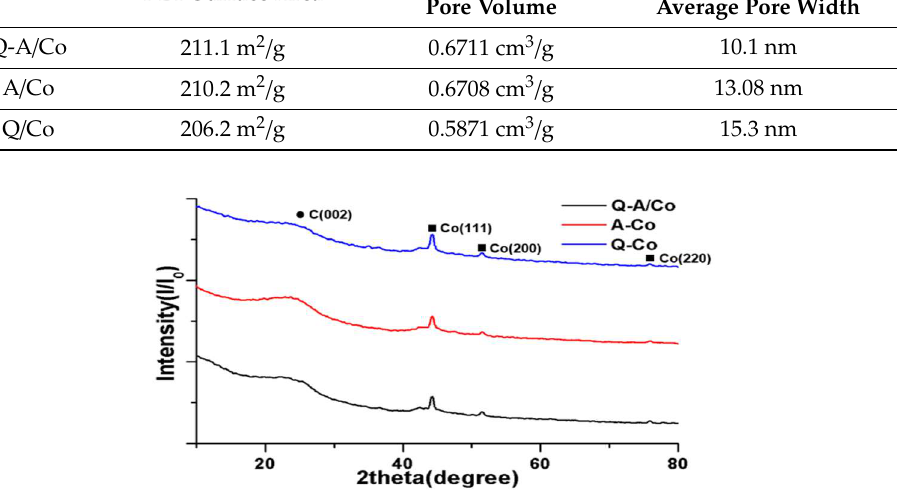
Figure 4. ( a ) BET isotherm linear plot of the three types of synthesized N-doped carbon. ( b ) Barrett- Joyner-Halenda (BJH) adsorption pore distribution of Q-A/Co. Table 1. Textural parameters of Q/A-Co derived from the N2 adsorption-desorption isotherms . BET Surface Area